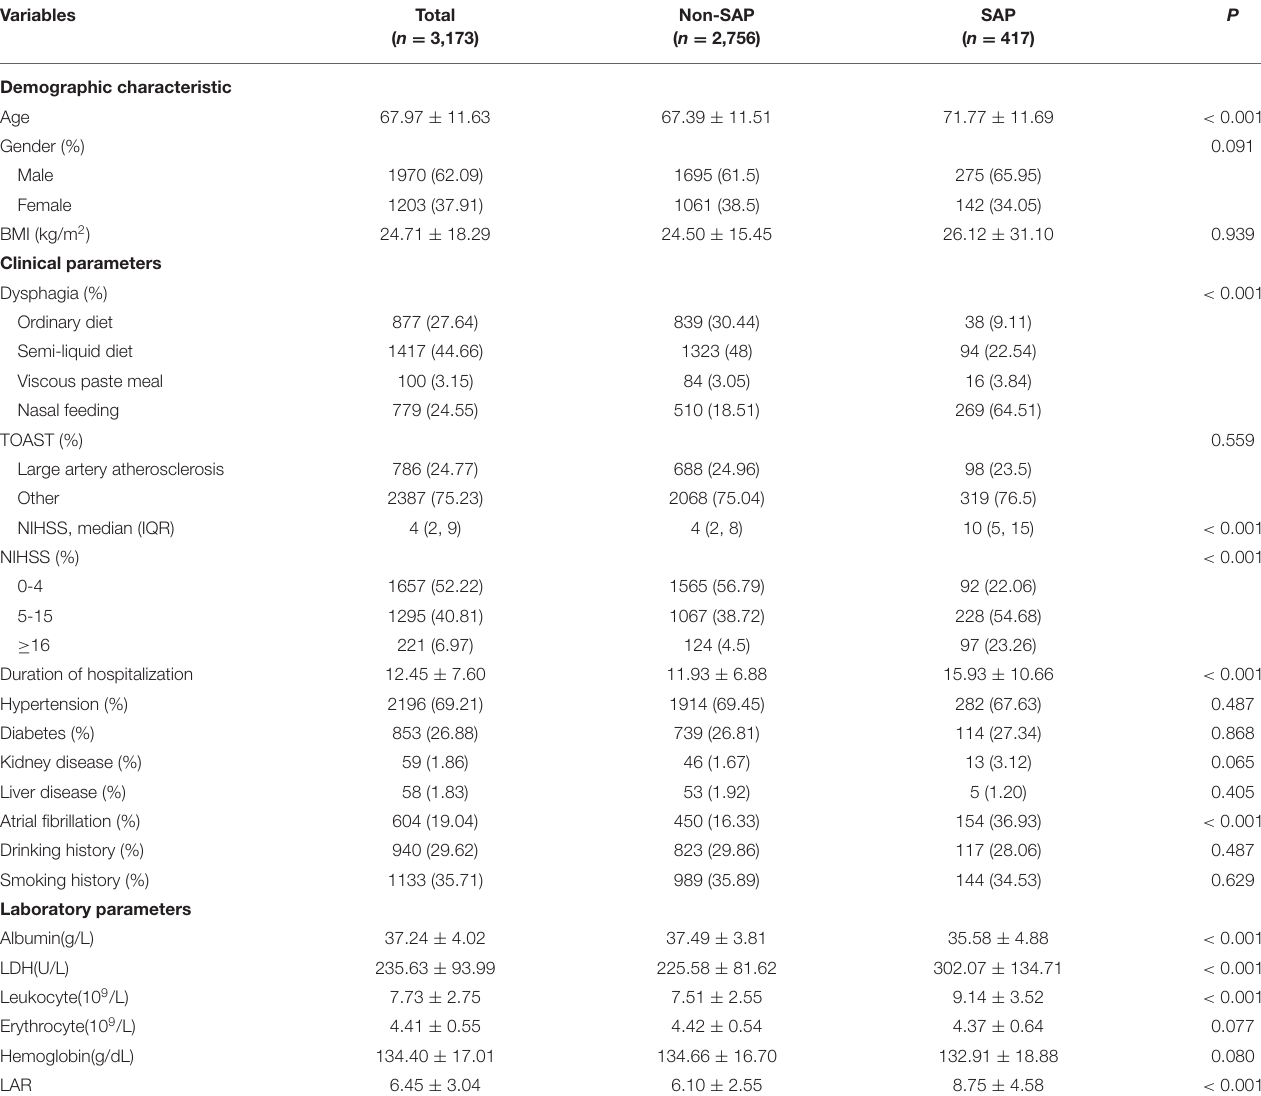
TABLE 1 | Comparisons of clinical characteristics between SAP and Non-SAP groups.